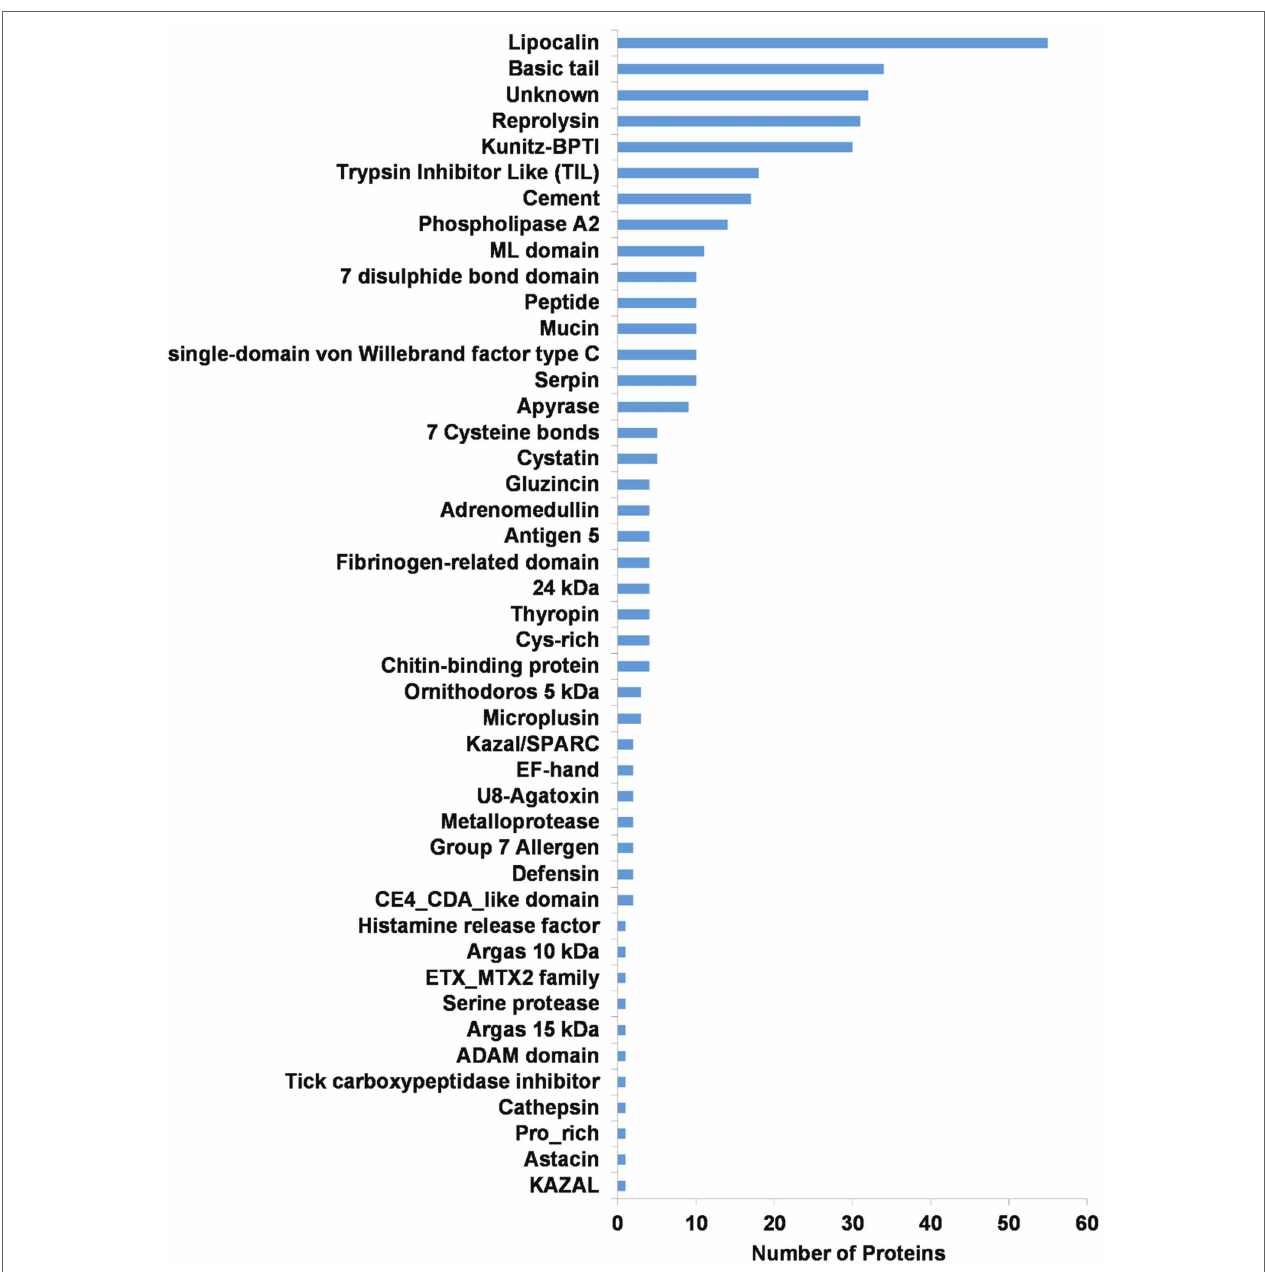
FIGURE 7 | Summary of the secretory protein families found in the salivary gland transcriptome of O. brasiliensis . Indicated are numbers of proteins for each